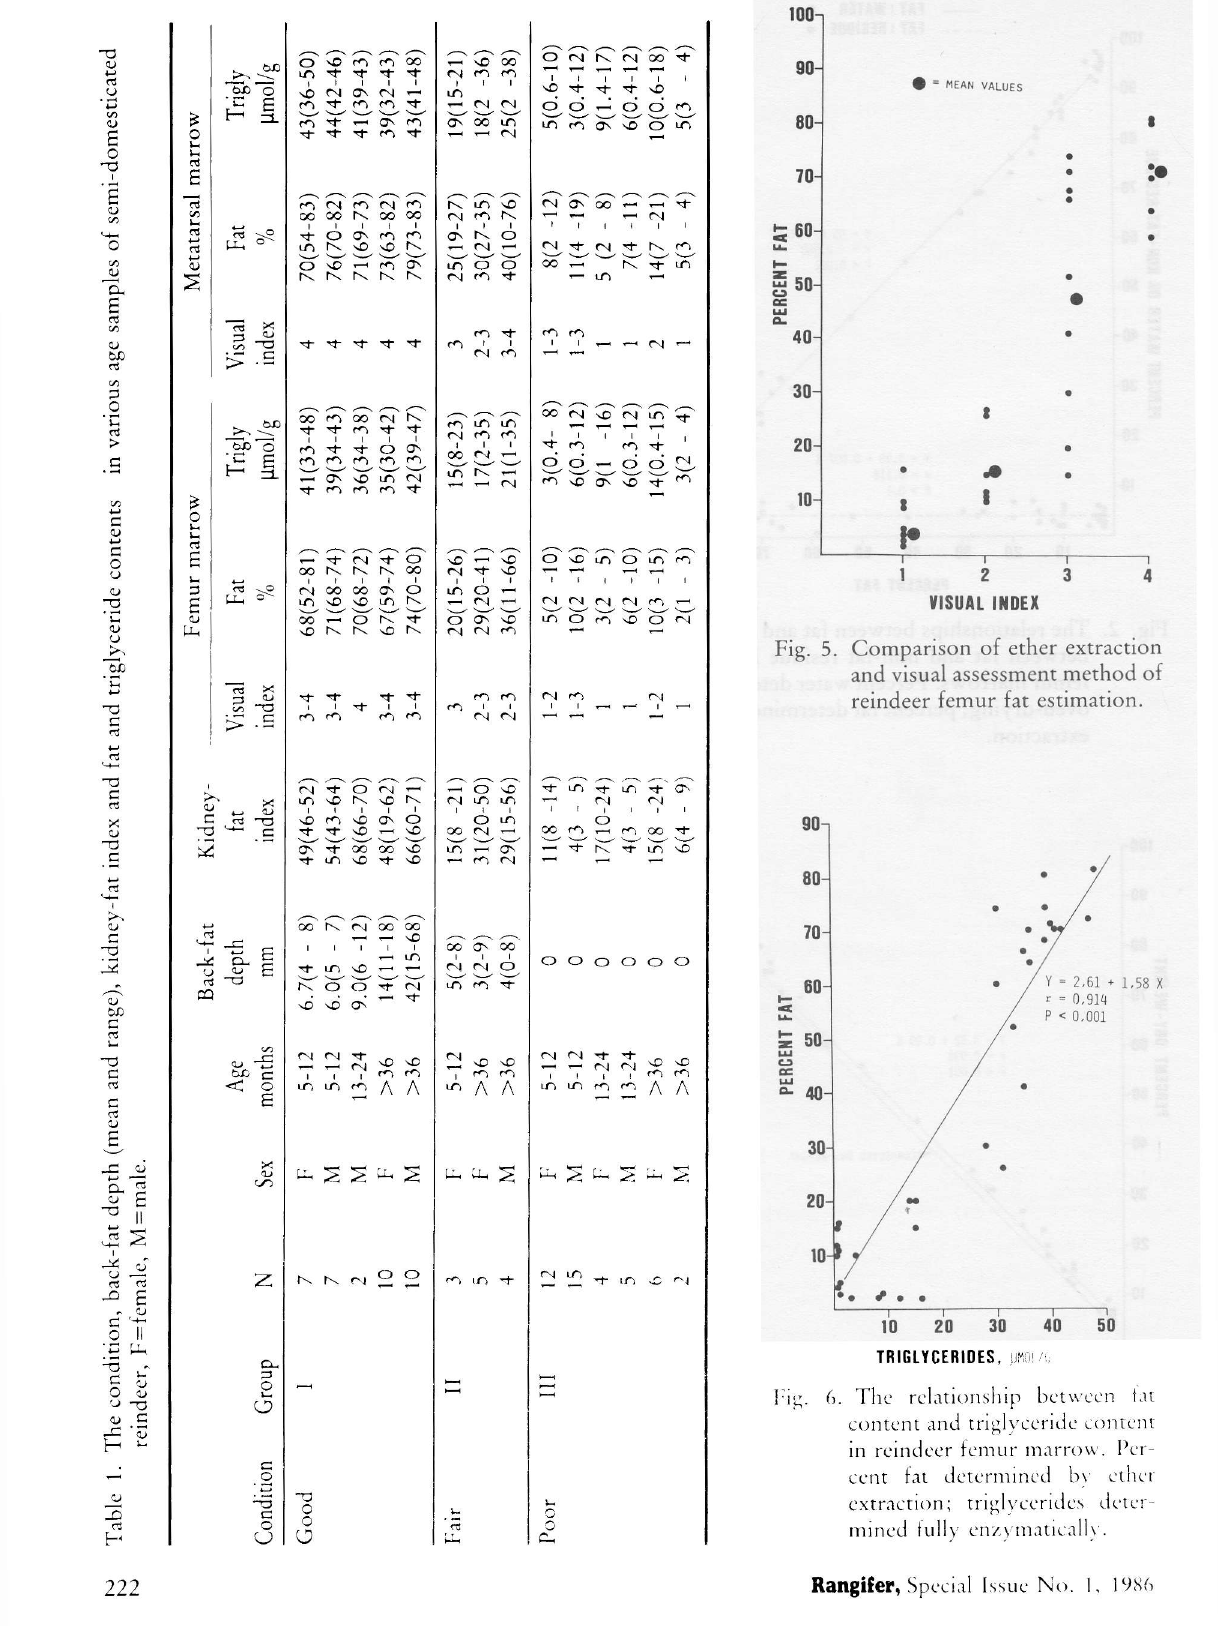
Fig. 5. Comparison of ether extraction and visual assessment method of reindeer femur fat estimation.